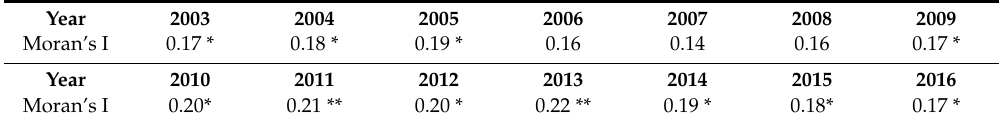
Table 2. Moran’s I statistic of carbon emissions from 2003 to 2016.